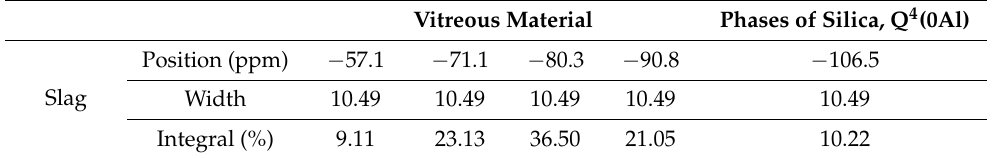
Table 1. Deconvolution of the 29 Si MAS-NMR spectra. Figure 3. 29 Si NMR spectra of the raw materials.